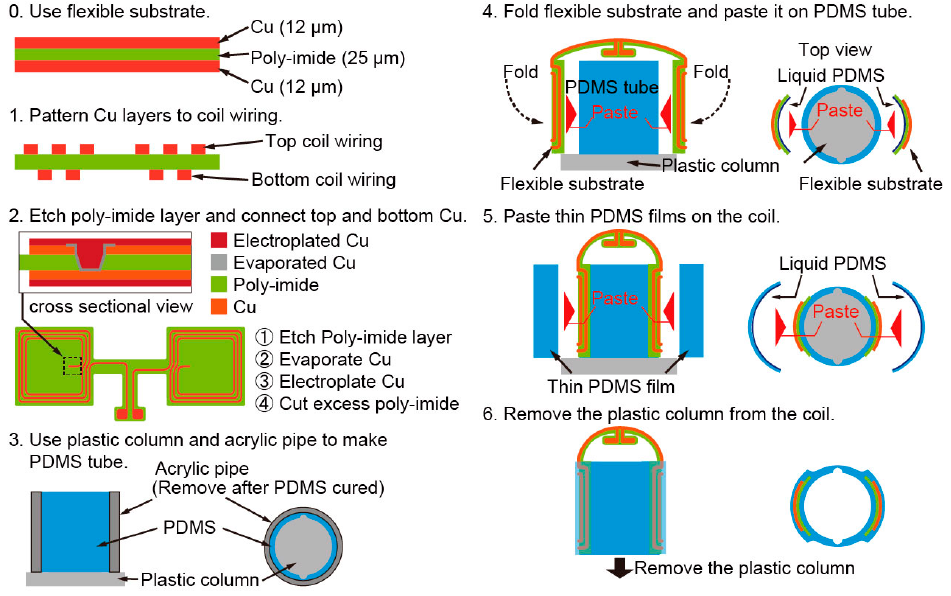
Figure 3. The fabrication process of the micro saddle coil.